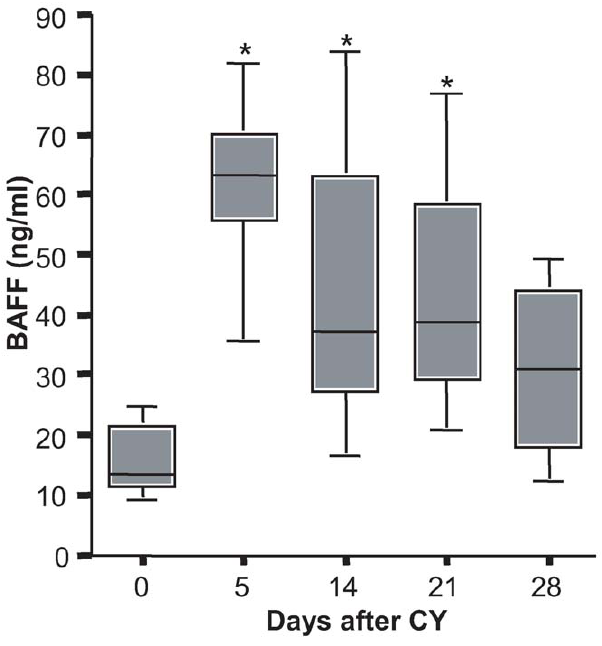
Figure 4. Elevation of serum BAFF during B cell reconstitution. Serum BAFF levels in five mice were measured by ELISA following administration of CY. BAFF was significantly elevated following 3 days after CY treatment and remained elevated until day 28. *p , 0.01 as determined by Mann-Whitney test.